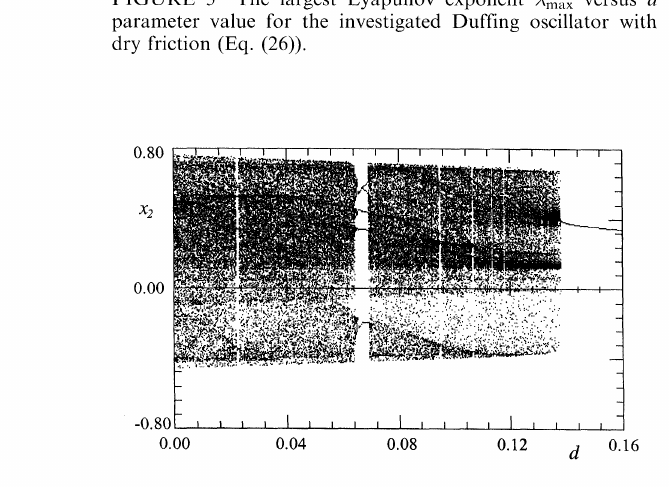
FIGURE 6 The bifurcation diagram of velocity x versus d parameter for Duffing oscillator with dry friction (Eq.